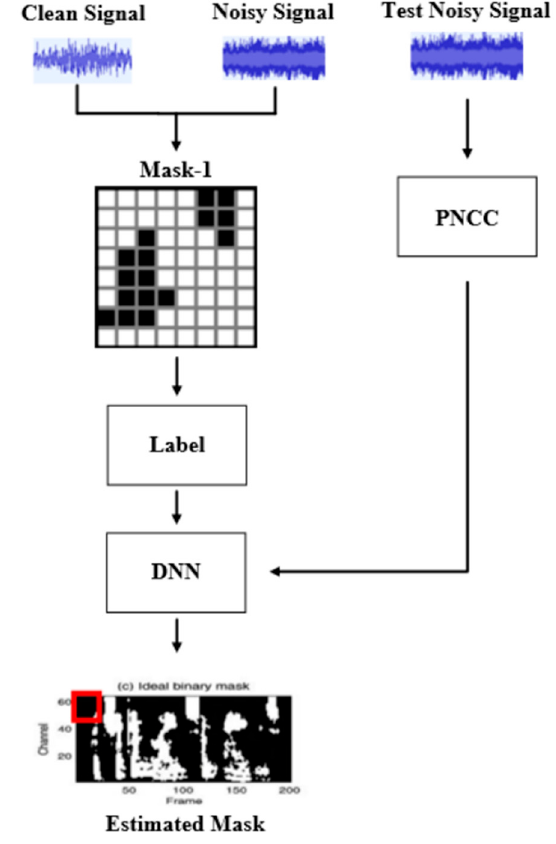
Figure 11. DNN trained per channel. Table 7. Scoring of DNN Layer and Channel